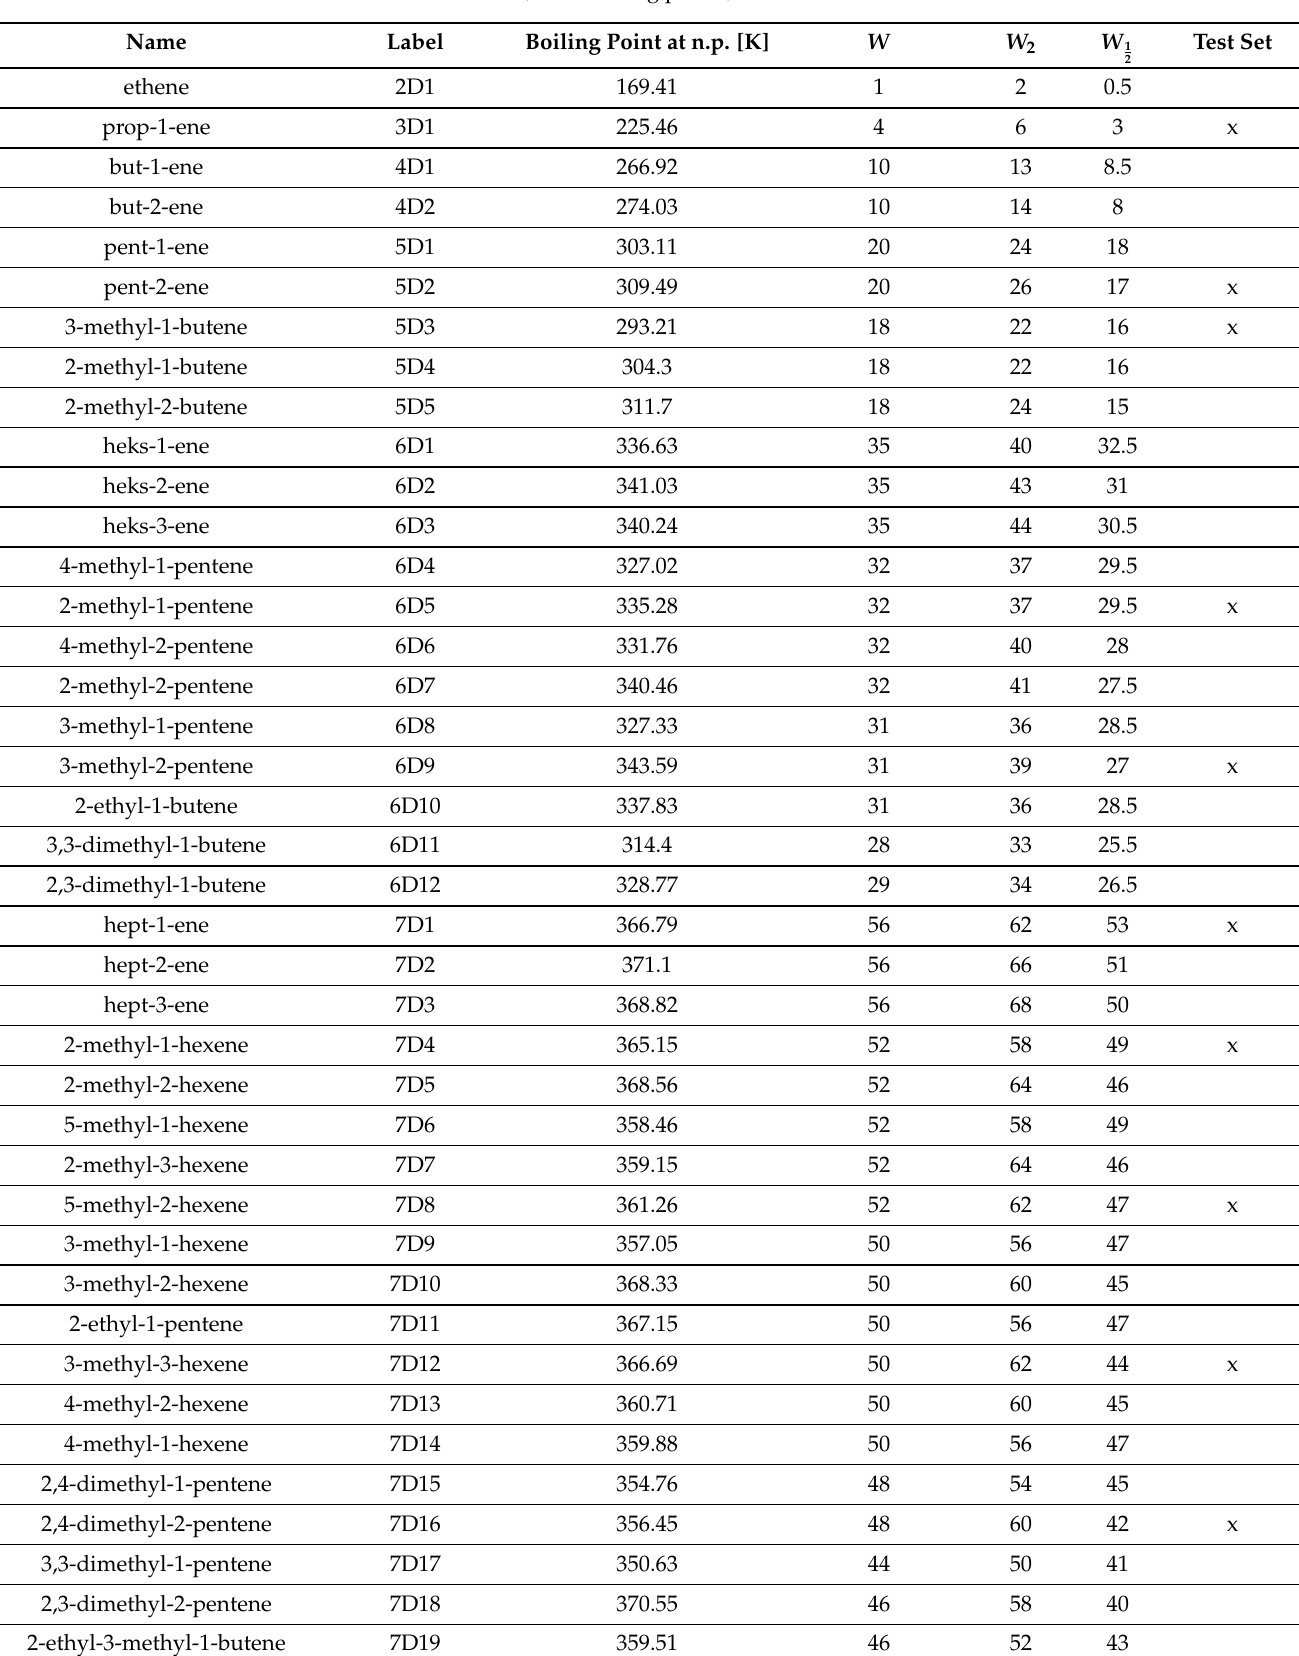
Table 2. Alkenes, their boiling points, and Wiener